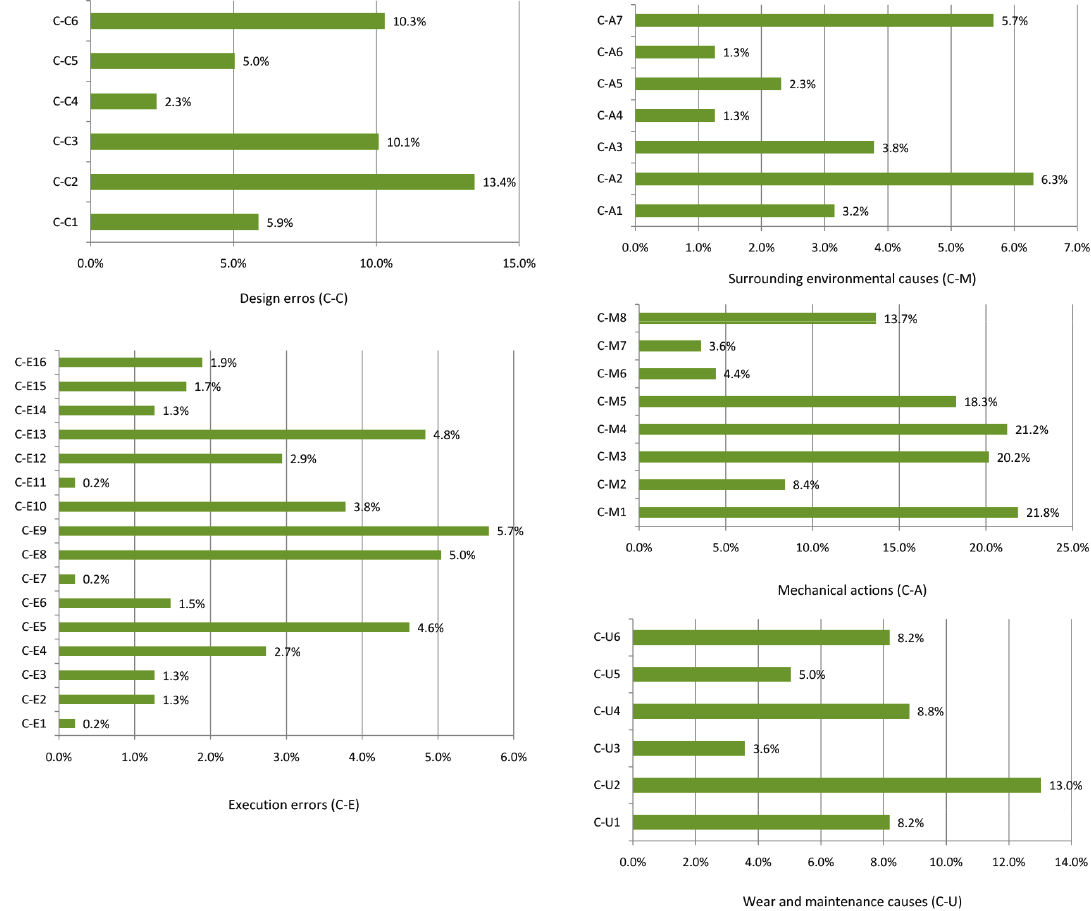
Fig. 7. Relative contribution of each group of causes to the anomalies